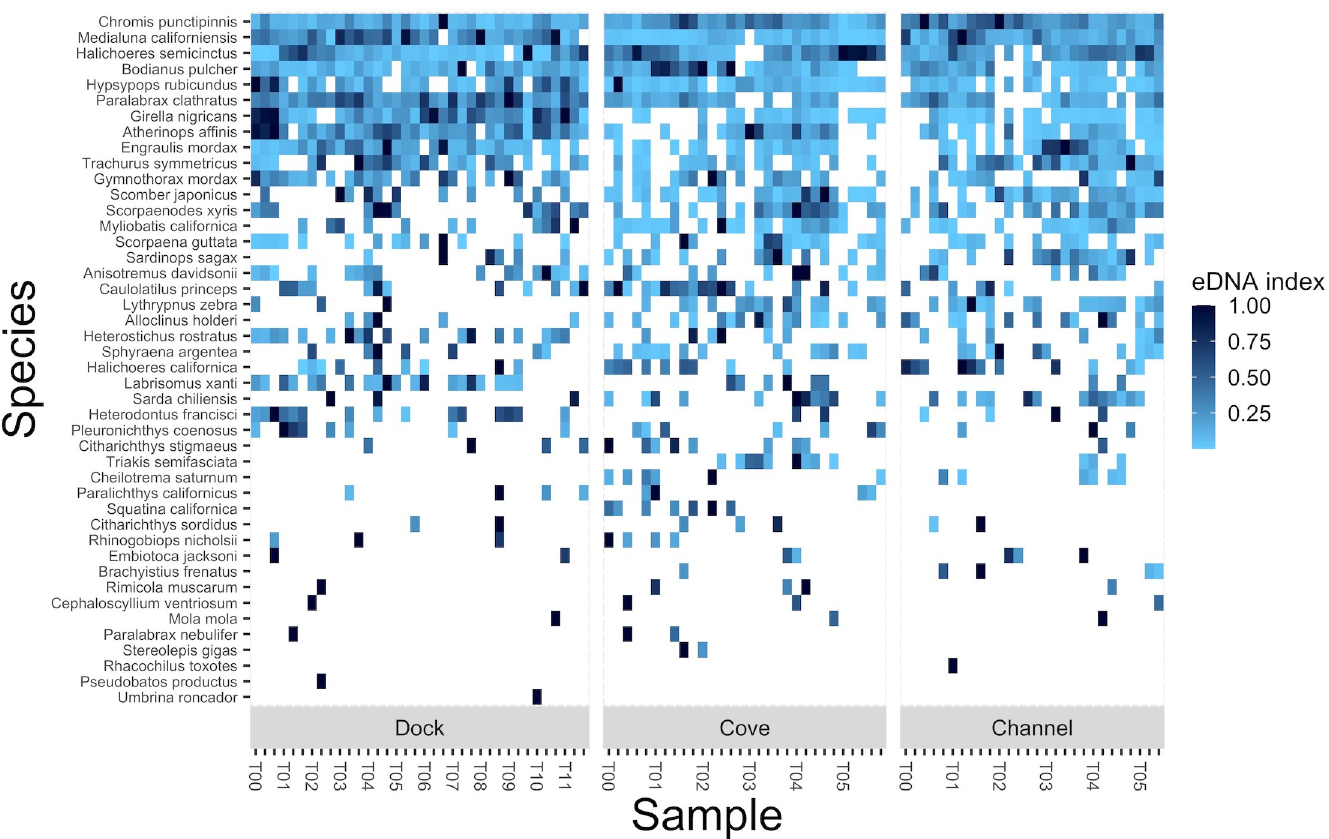
Fig 3. Heat map of species monitored by KFM, PISCO, and reef check detected over time. Heat map showing strength of the eDNA index for species monitored by KFM, PISCO, and Reef Check observed separated by transect: dock, cove, and channel. Darker blue indicates higher index values. White indicates the species was not detected. Samples are ordered by time and then by replicate (A to E) with only the first sample per time point labeled. Species are ordered by decreasing total detections.